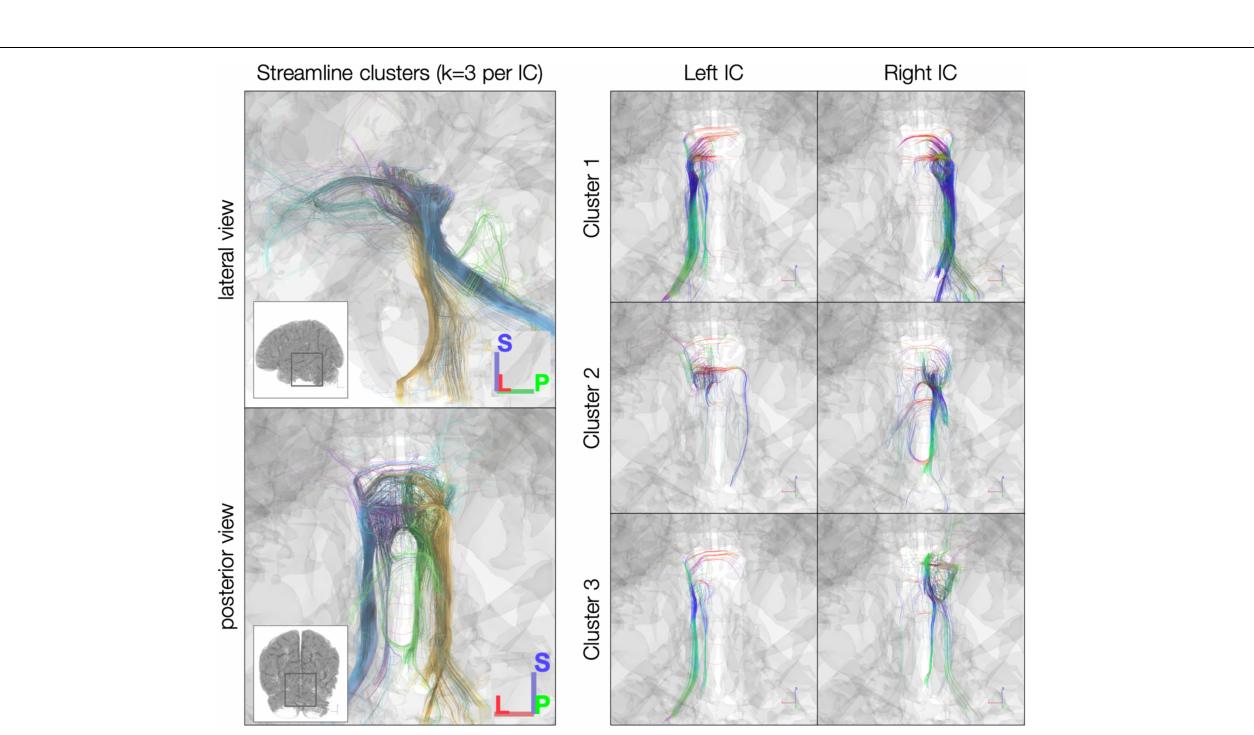
FIGURE 5 | k -Means clustering [ k = 3 per inferior colliculus (IC)] of the in vivo 760 µ m dataset. Left: color denotes cluster (1, 2, or 3, based on k -means clustering). Right, color denotes local streamline orientation; blue, superior–inferior; red, left–right; green, anterior–posterior.